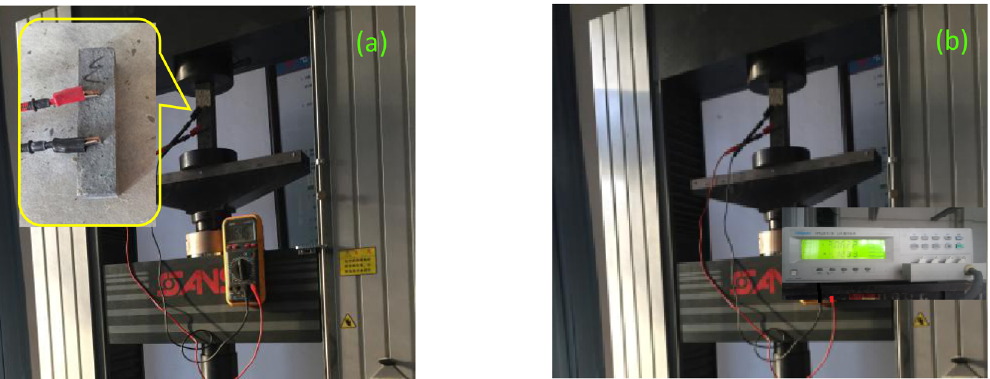
Figure 2: The piezoresistive test con fi guration of MNTSM or MNT/CM with two - electrode method: ( a ) DC resistance ( yellow box – MNTSM or MNT/CM specimen with two electrodes ) ; ( b ) AC